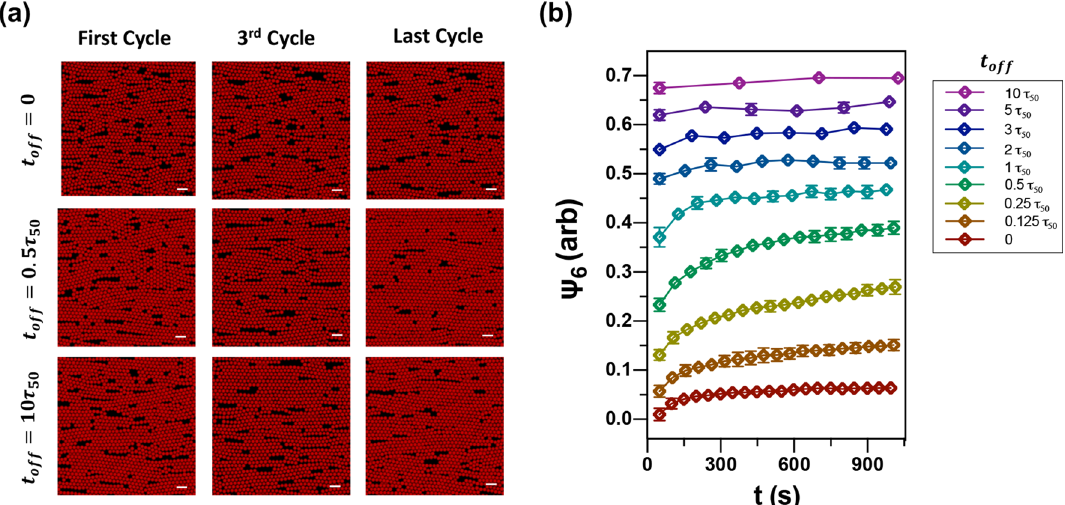
Figure 3. The impact of t off on colloidal crystal quality for simulated systems. ( a ) Images of simulated spheres assembled into dense crystals with t off = 0, 0.5 τ 50 and 10 τ 50 at the first, third and last cycle, respectively. ( b ) Time evolution of ψ 6 data for cycled-fields simulations with nine different durations of t off . Data in ( b ) are offset for clarity. Scale bars in images are 10 μm. This data over the full range of long-cycle times can be found in Supplementary Fig.